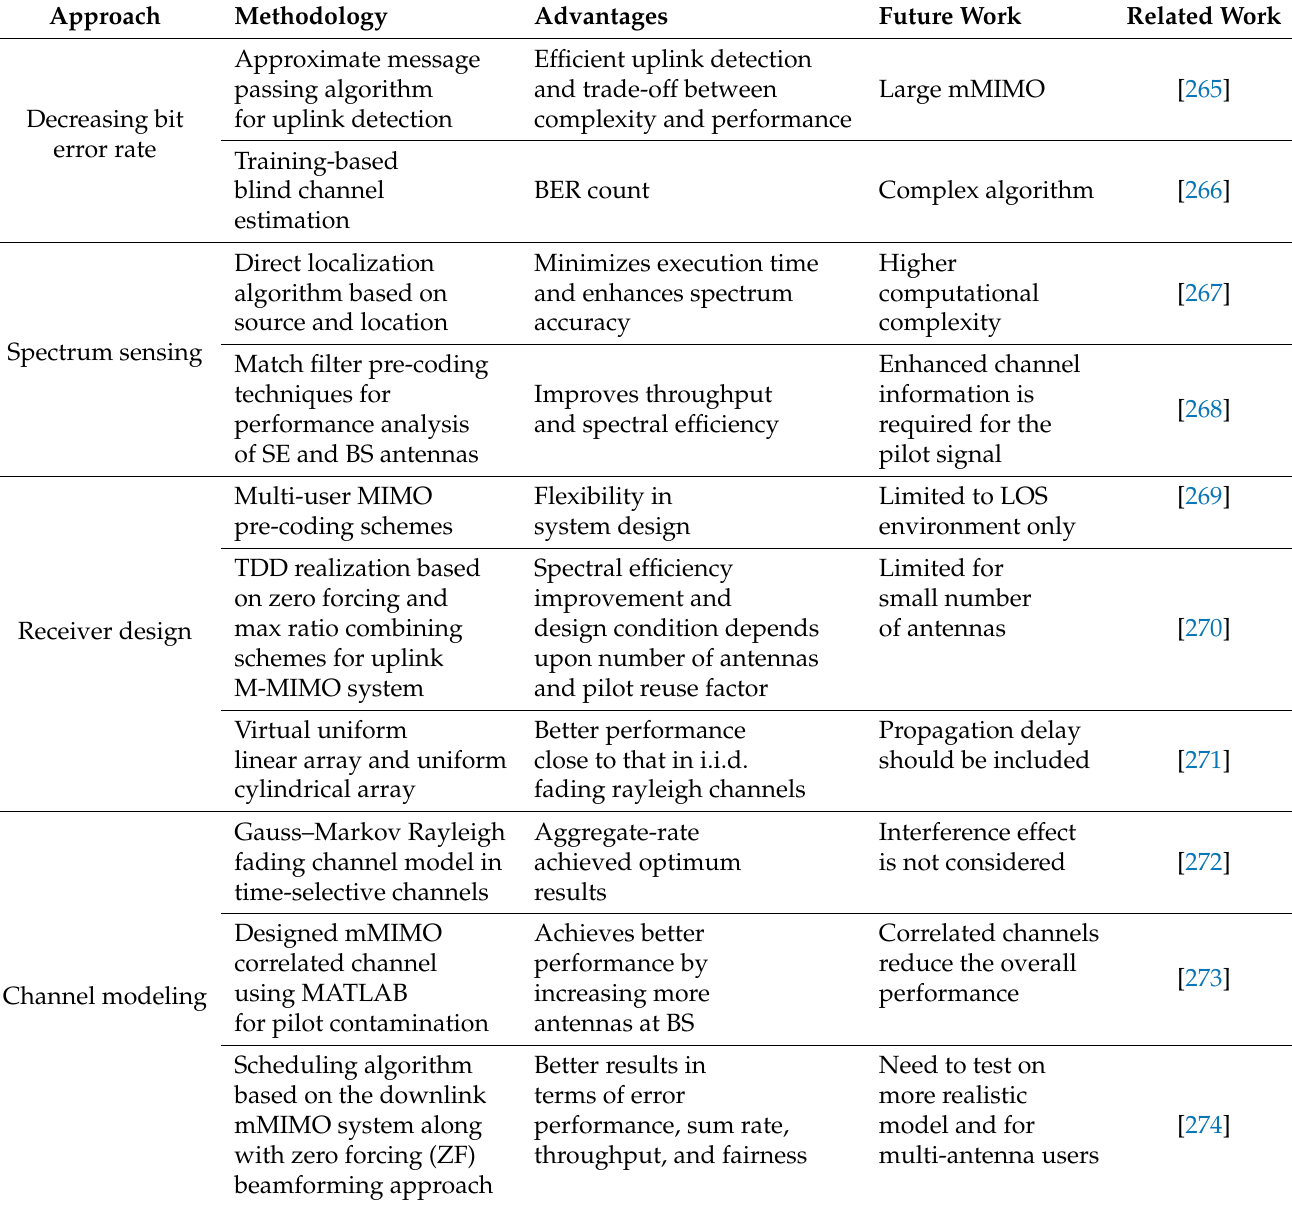
Table 8. Summary of studies on massive